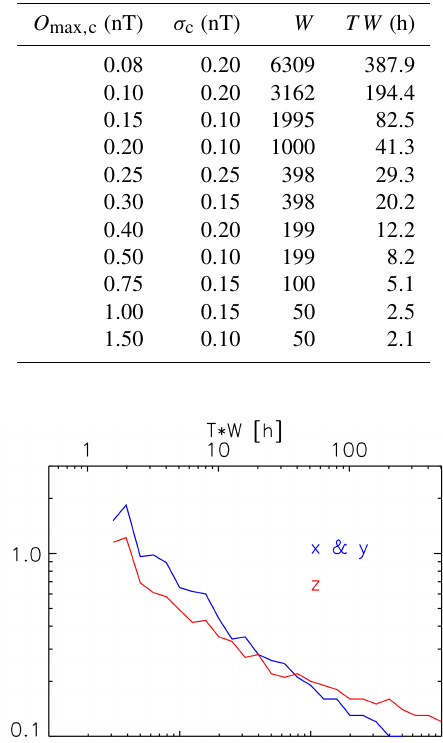
Table 1. Optimal parameters σ c and W as well as minimum so- lar wind measurement times T W to achieve offset uncertainties ≤ O max , c based on O max ,xy values shown in Fig. 3a.